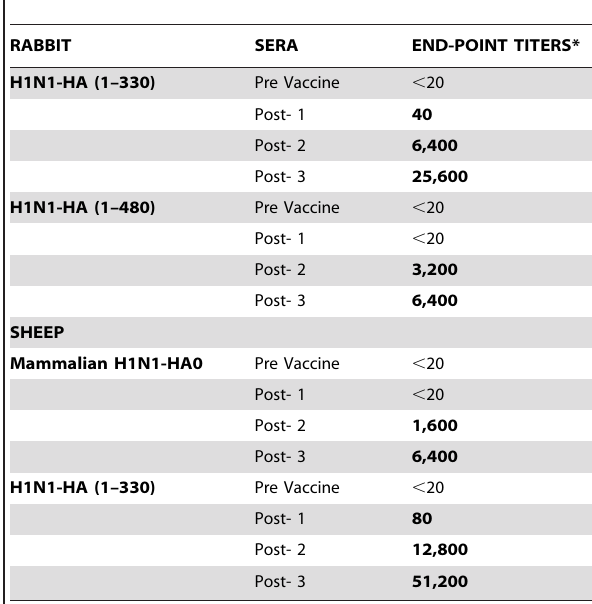
Table 2. Mean reciprocal neutralizing titers of Rabbit and Sheep anti-HA